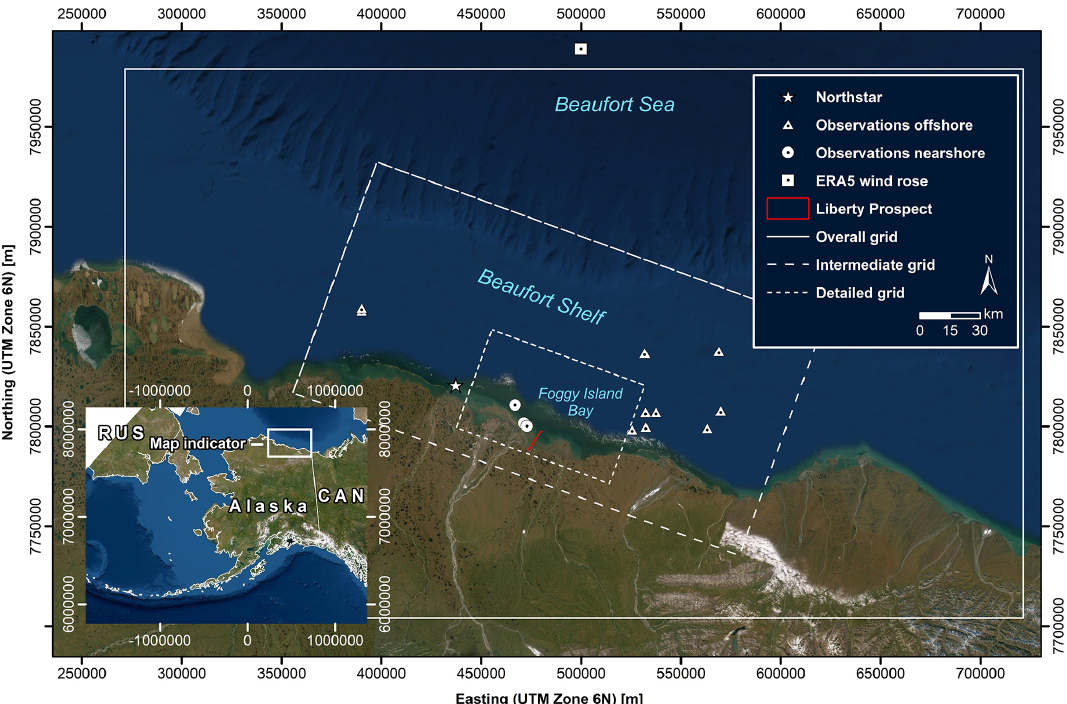
Figure 1. Map showing the study area and vicinity including instrumented wave observation locations used for calibration and valida- tion, Northstar, Liberty Prospect, model grids, and the wind rose location. © Esri, DigitalGlobe, GeoEye, Earthstar Geographics, CNES (Centre national d’études spatiales)/Airbus DS (Defence and Space), USDA (United States Department of Agriculture), USGS (United States Geological Survey), AeroGRID, IGN (Institut géographique national), and the GIS (geographic information system) user community. UTM: Universal Transverse Mercator. CAN: Canada. RUS: Russia.